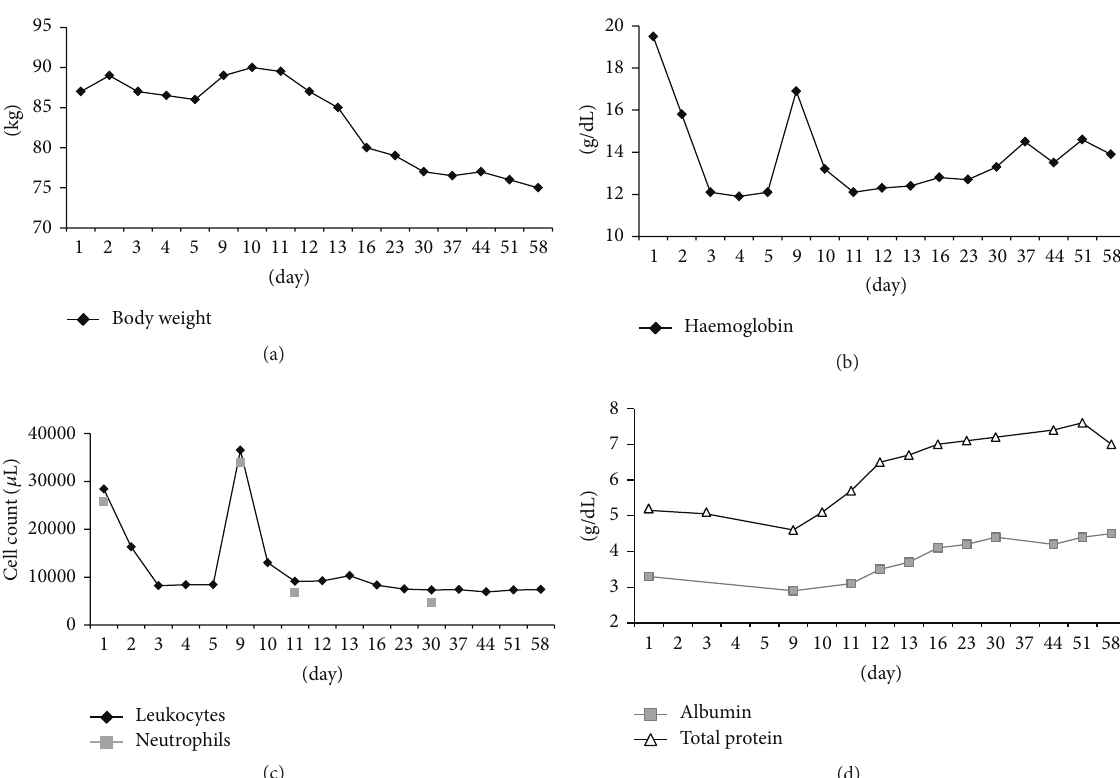
Figure 1: Time course of body weight, haemoglobin, leukocyte and neutrophil counts, and albumin and total protein levels of the described patient. SCLS attacks occurred on days 1 and